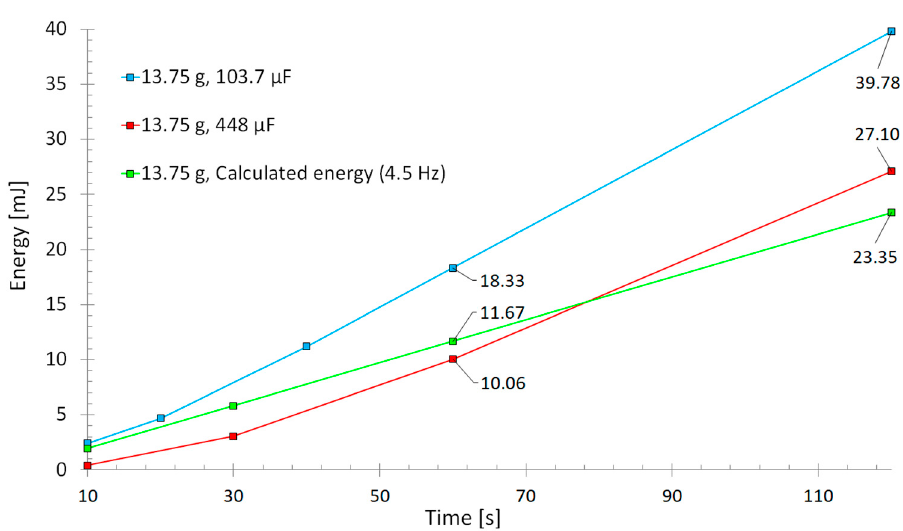
Figure 9. Harvesting electronics comparison. Blue and red lines indicate energy from capacitors loaded trough rectifier. Green line is calculated energy from measured voltage through a rectifier and over a load.